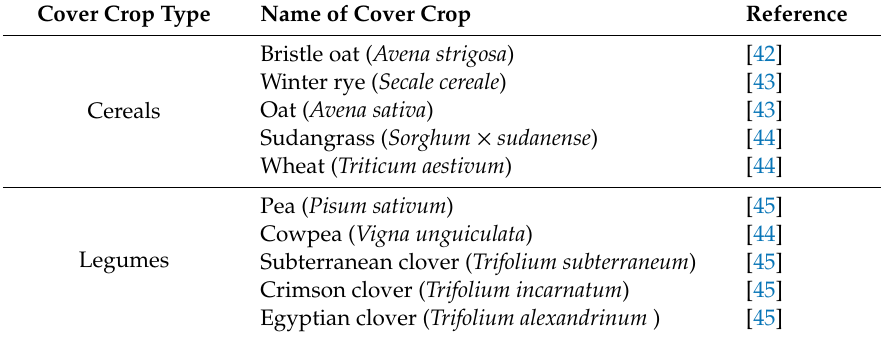
Table 1. A list of important cover crops used for weed control and other ecological